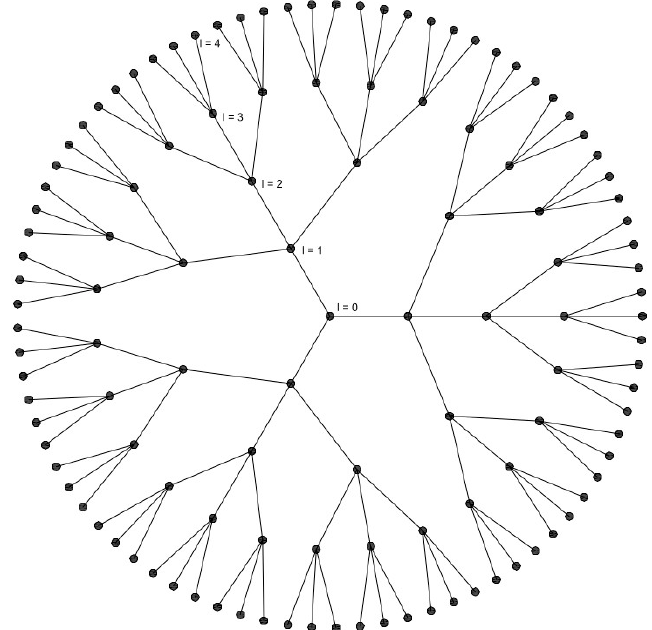
Figure 1. Example of a Cayley regular graph with five levels ( L = 5) and a bifurcation ratio of X = 3 (solid lines represent actual links). The symbol l represents the number of the level counted from the origin, so l = 0, 1, 2, 3, 4.